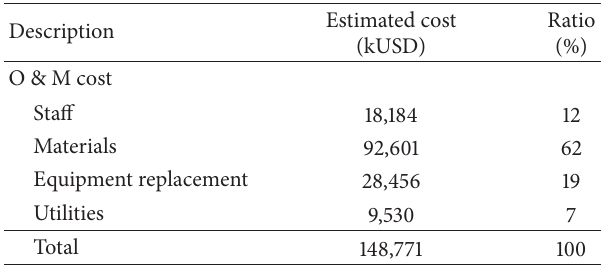
Table 4: Investment costs of SFR fuel cycle facilities. Table 5: Annual operation costs of SFR fuel cycle